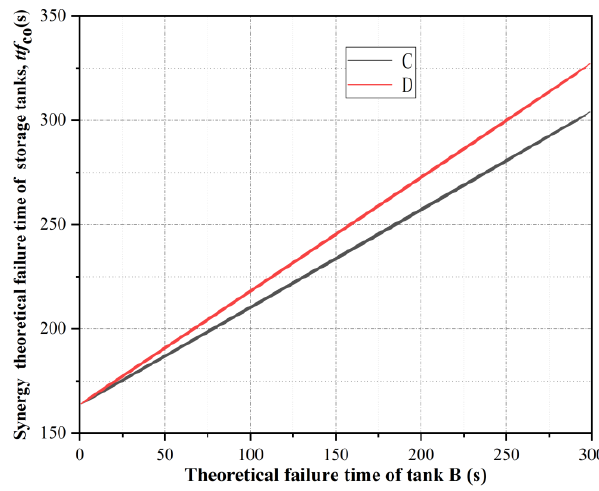
Figure 7. Synergy theoretical failure time of tanks C and D.